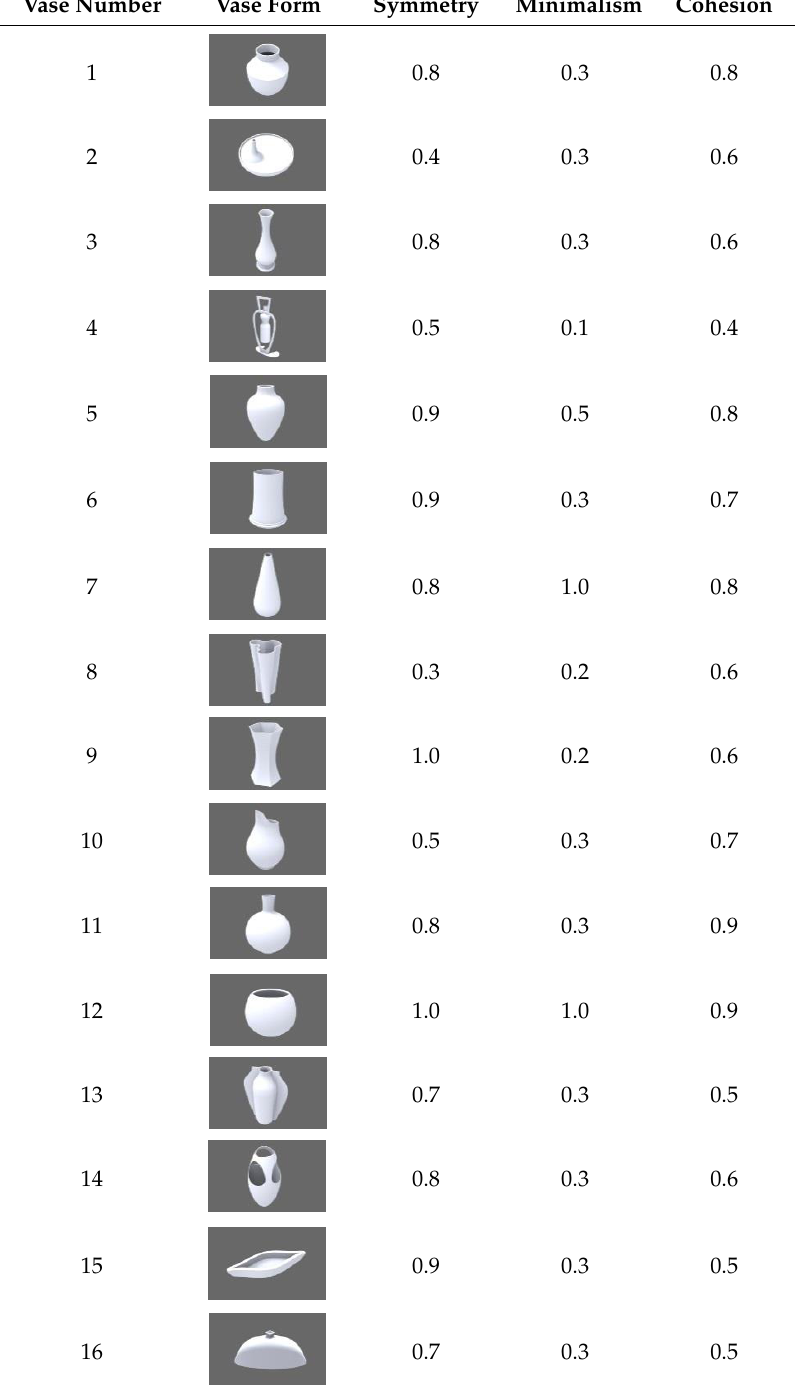
Table 2. Presentations of 21 vases in the aesthetic principles.